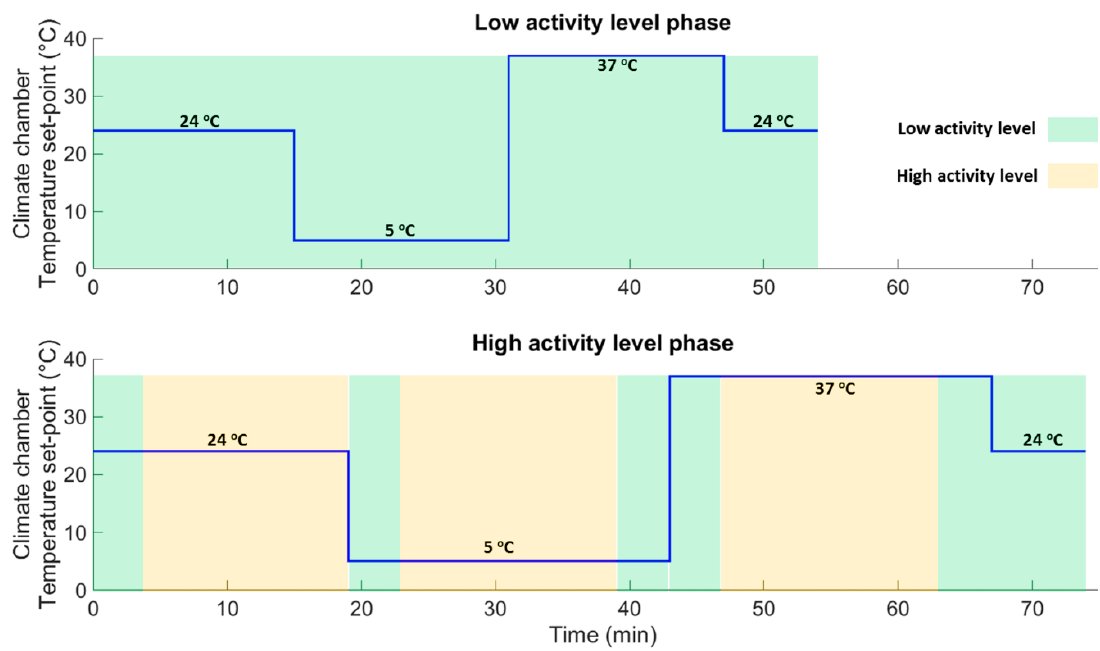
Figure 4. Plots showing the climate chambers’ set-point temperatures programmed during the 55 min low activity phase ( upper graph ) and the 75 min high activity phase ( lower graph